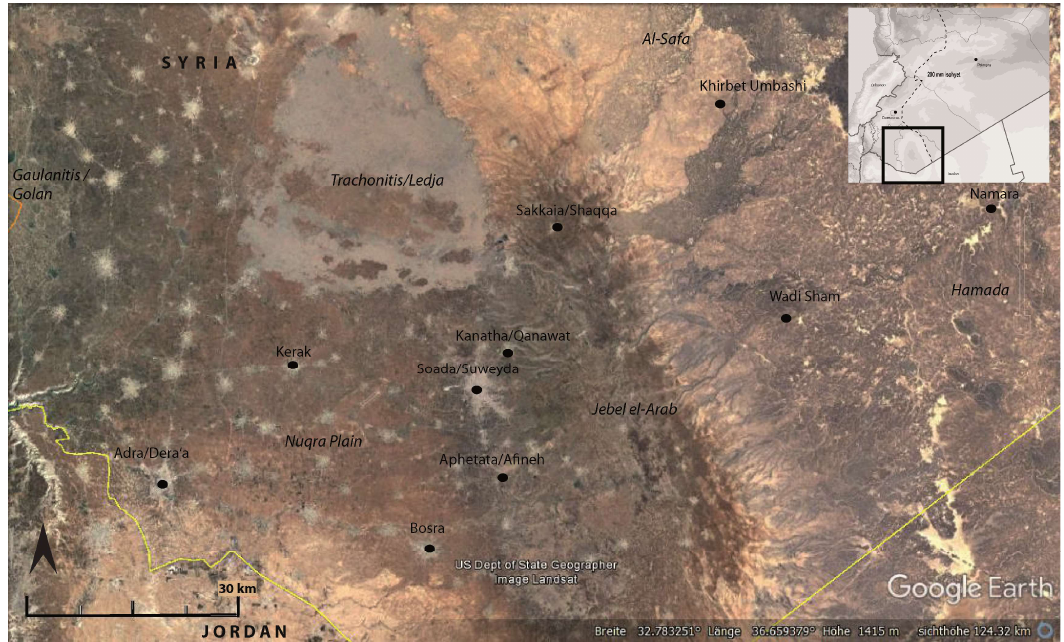
Figure 2. Satellite image of the northern parts of the arid landscape of Hauran (Southern Syria) showing geographical units and settlements referred to in the text. Created with Google Earth V 7.3.2.5495 (Google, Mountain View, CA, USA). Image: Landsat/Copernicus 2016, as base